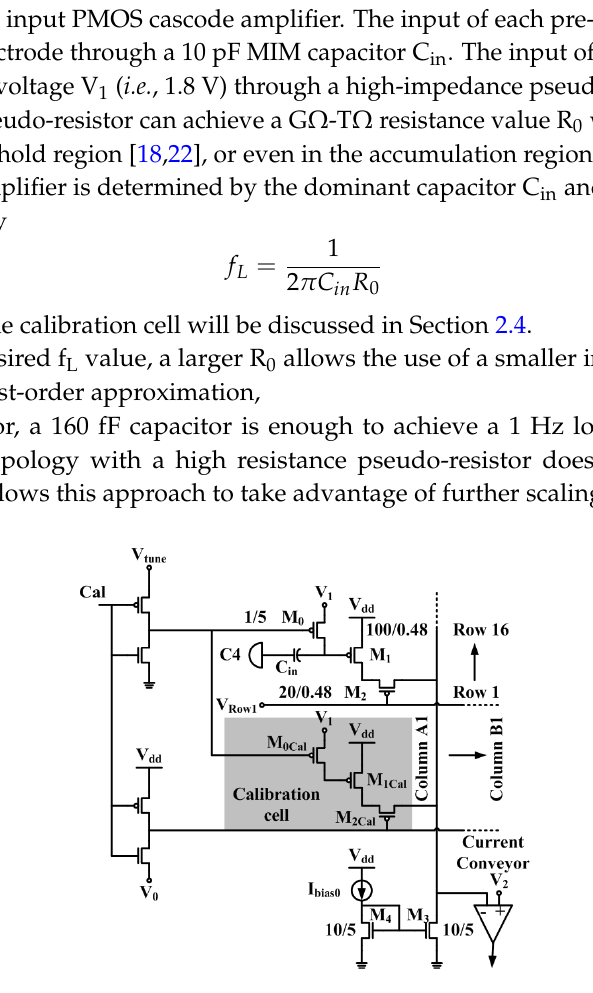
Figure 4. Circuit schematic of the pre-amplifier array. The calibration cell has the same size as a regular pre-amplifier, only without being connected to a C4 input electrode. There is one calibration cell on each column. The substrates of NMOS and PMOS devices are connected to the ground and the 2.5 V power supply,